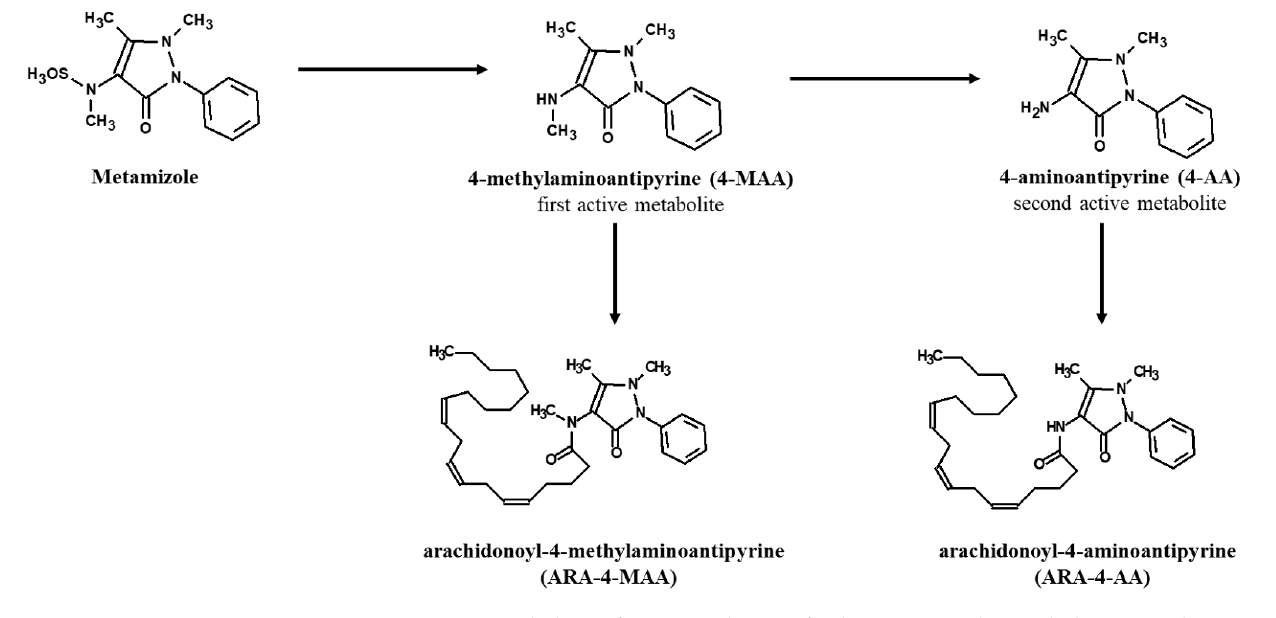
Figure 2. Hepatic metabolism of metamizole. Two further metamizole metabolites were discovered, representing the arachidonoyl amides of 4-MAA and 4-AA (adjusted after Lutz, 2019, [32]).